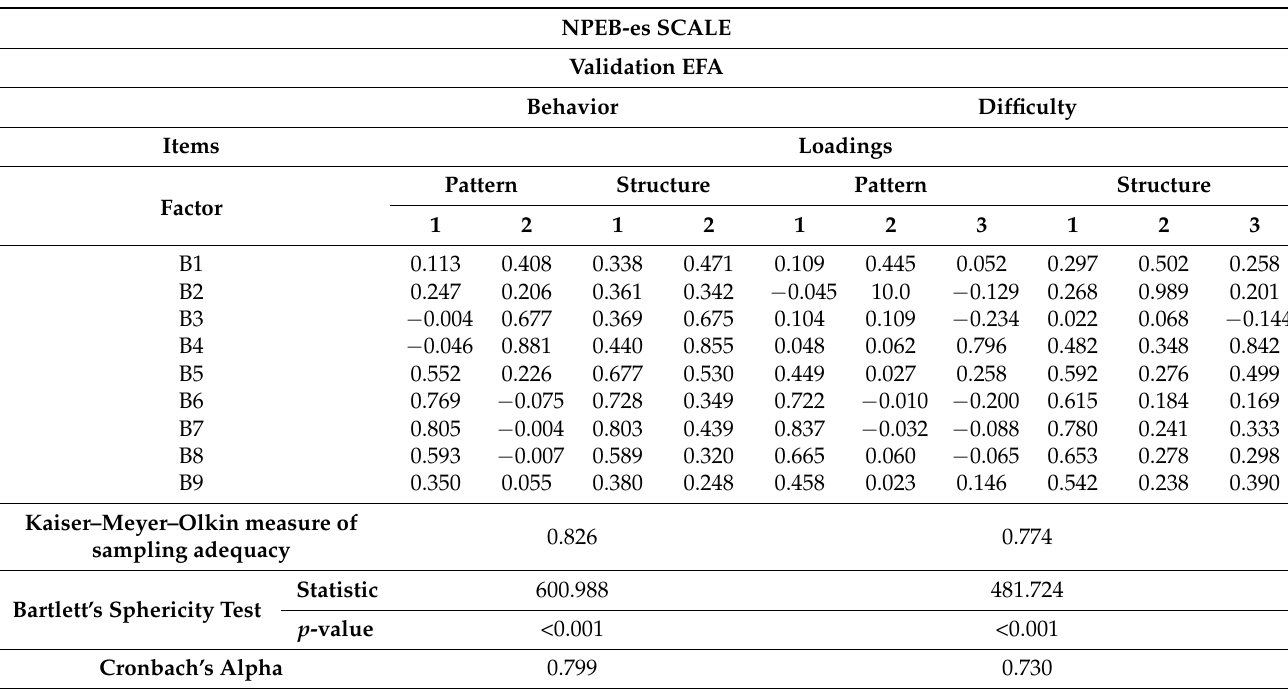
Table 4. Factor loadings and Cronbach’s alphas for the Nurse Professional Ecological Behaviors